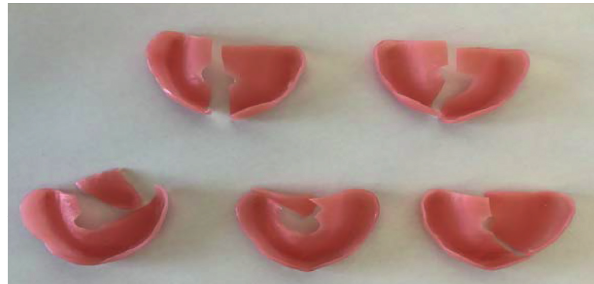
Figure 14: Megacryl ® prosthesis bases subjected to pH 7 after fracture.